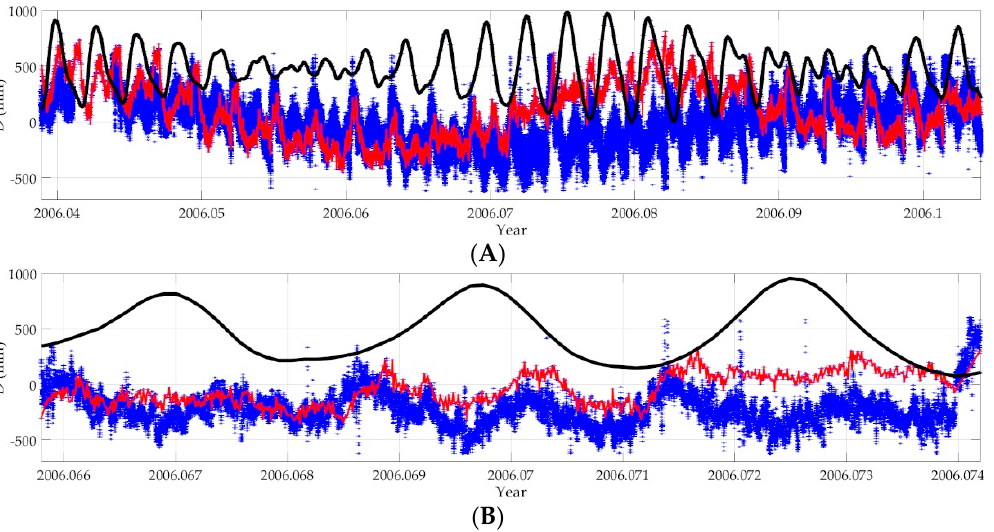
Figure 10. DRY1 East ( red ) and North ( blue ) components with respect to the predicted tide signal ( black ); ( A ) whole series, ( B ) a detail around tide daily signals. To highlight some correspondence between the surface morphology and the survey carried out at sites, comparisons were made with the Reference Digital Elevation Model of Antarctica REMA [40] along the profiles having the same horizontal directions as the control point (Figure 11).